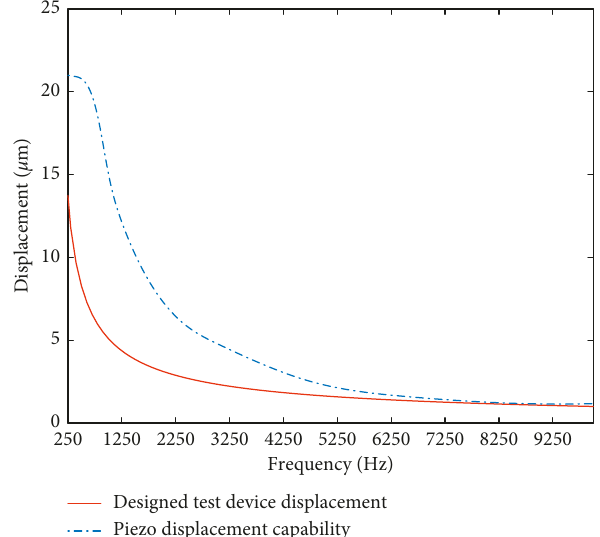
Figure 11: The piezoelectric actuator displacement capability and the needed displacement for the new DMA